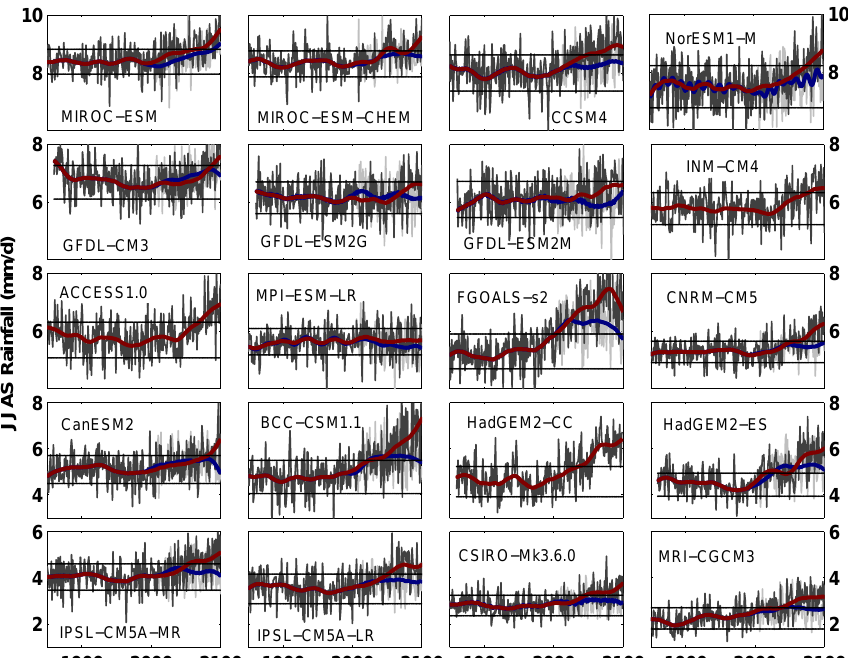
Fig. 4. Indian summer monsoon seasonal (June–September) mean rainfall for the period 1850–2100 from the 20 comprehensive climate models. Gray shadings represent the yearly values, and red and blue lines represent the nonlinear trend in seasonal mean rain obtained from a singular spectrum analysis with a window width of 21yr for RCP-8.5 and RCP-2.6 respectively. The non-linear trends are calculated using a routine from Aslak Grinsted, and the method is discussed in Moore et al. (2005). The horizontal black lines represent mean ± standard deviation for each model for the period 1871–2004, which shows the range of baseline variability.